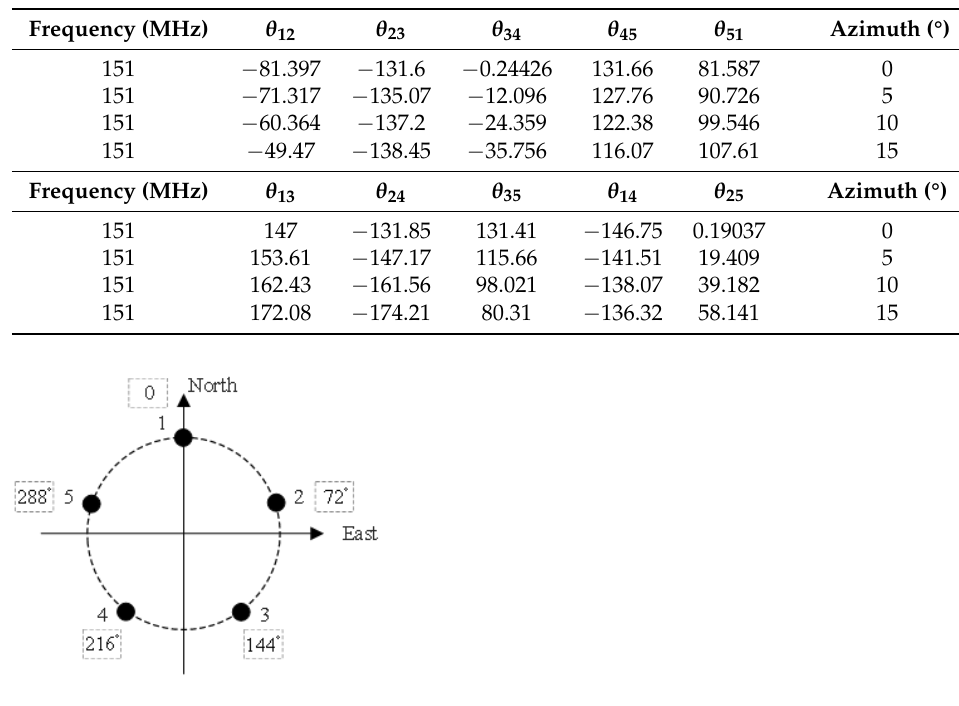
Table 1. The phase difference between the elements of some actual signals.